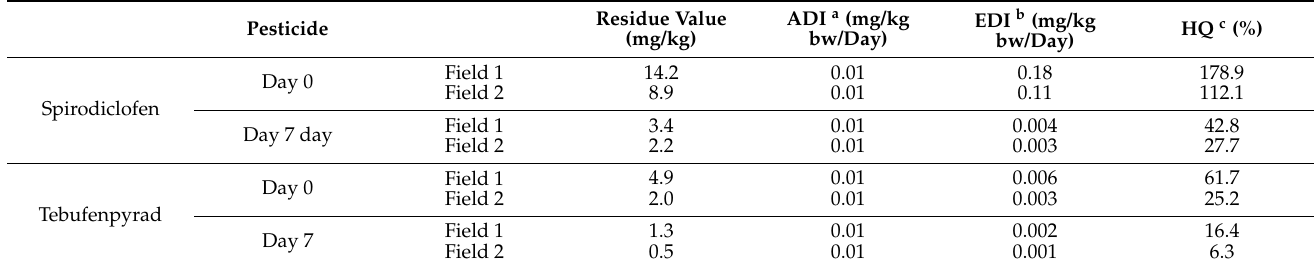
Table 5. Risk assessment of spirodiclofen and tebufenpyrad in Aster scaber